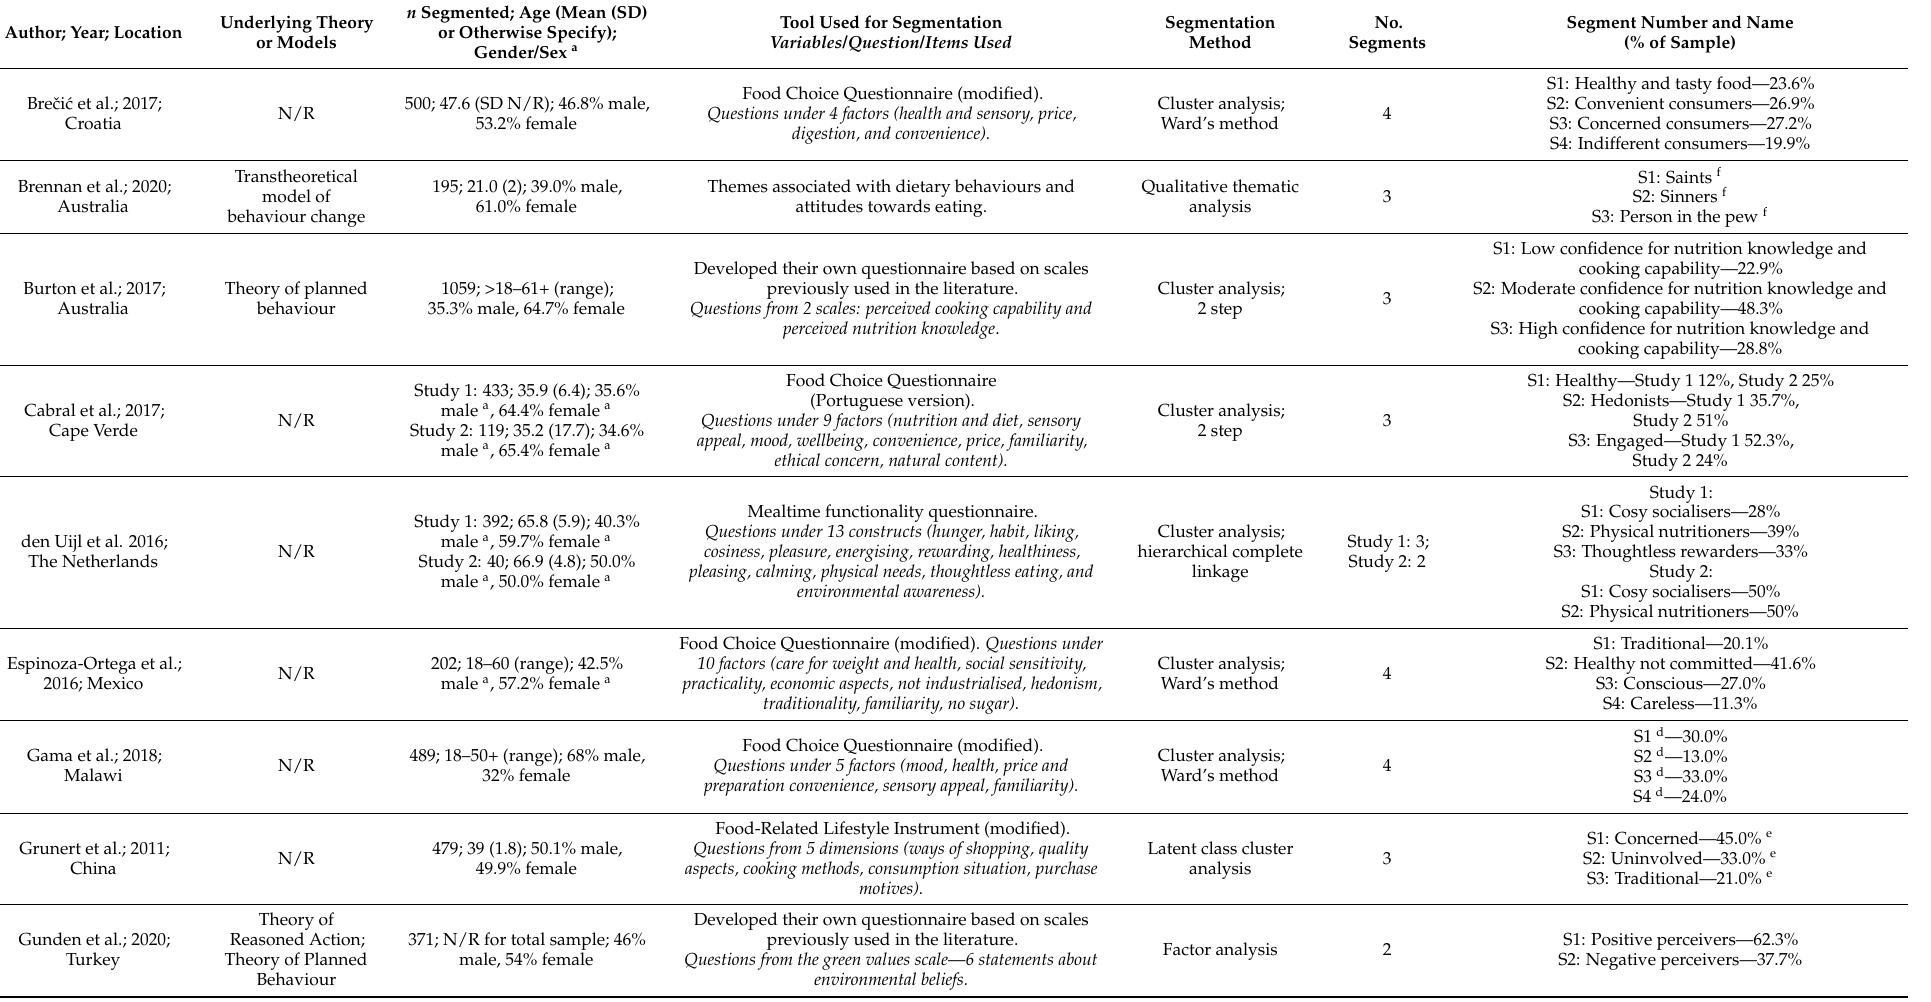
Table 1. Included studies and the tools used for segmentation, number of segments generated and their